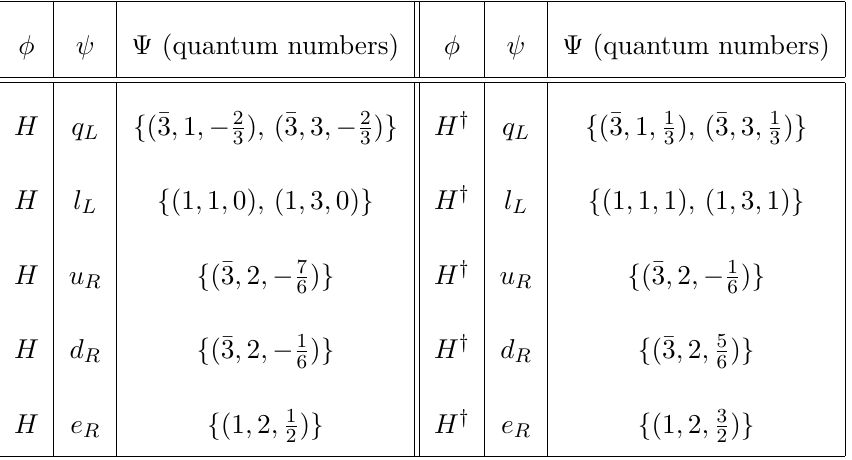
Table 2. Lists of heavy field quantum numbers for different choices of the light scalar and light fermion in the vertex V 4